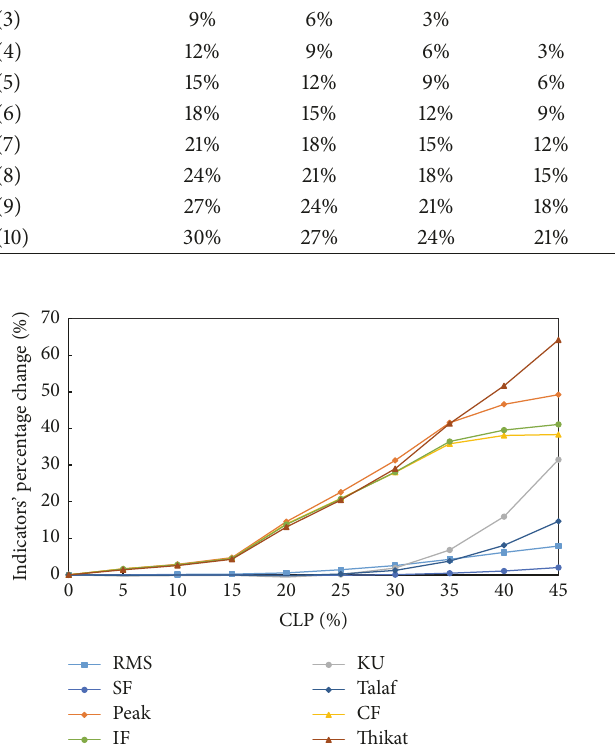
Figure 23: Performance of different time domain indicators applied to the original signal.